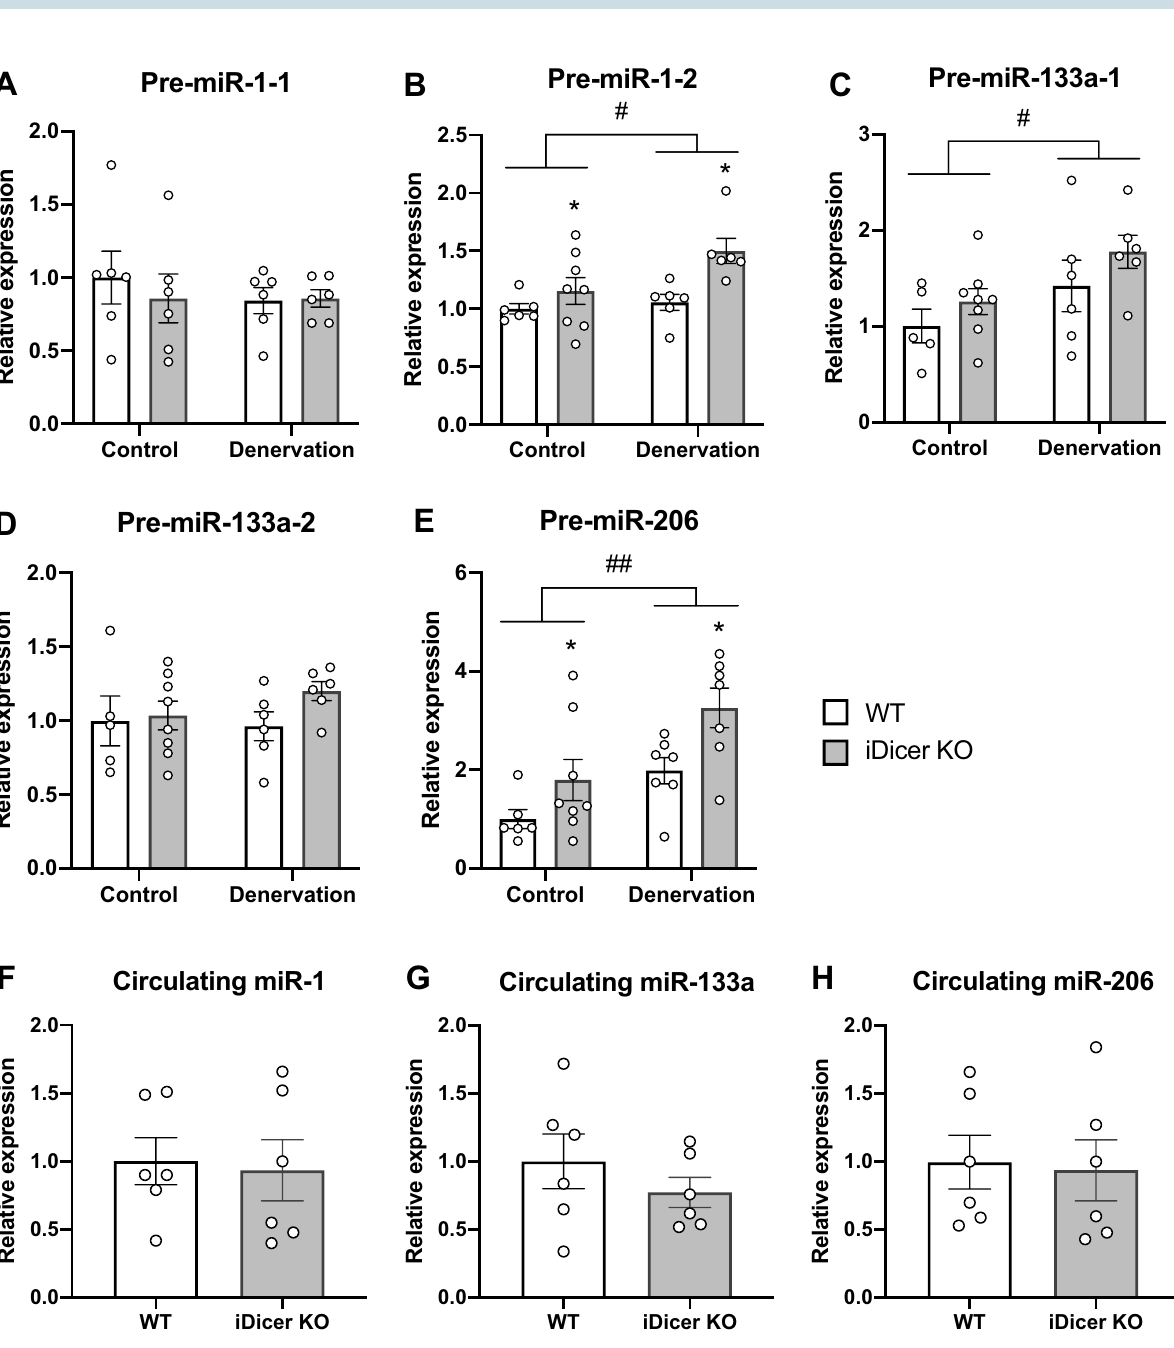
Figure 3. The expression levels of pre-miRNAs in plantaris muscles and circulating miRNAs in plasma after 2 weeks of denervation. ( A – E ) Expression of pre-miR-1-1, pre-miR-1-2, pre-miR-133a-1, pre-miR-133a-2 and pre-miR-206 (n = 4–8) after 2 weeks of denervation. Two weeks of denervation increased pre-miR-1-2, miR- 133a-1 and pre-miR206 levels in the plantaris muscles in both genotypes. In both innervated and denervated Dicer knockout muscles, increased pre-miR1-2 and pre-miR-206 levels were observed. ( F – H ) Tamoxifen- inducible deletion of Dicer did not affect circulating miR-1, miR-133a and miR-206 levels in plasma (n = 6). *P < 0.05 vs WT, # P < 0.05, ## P <